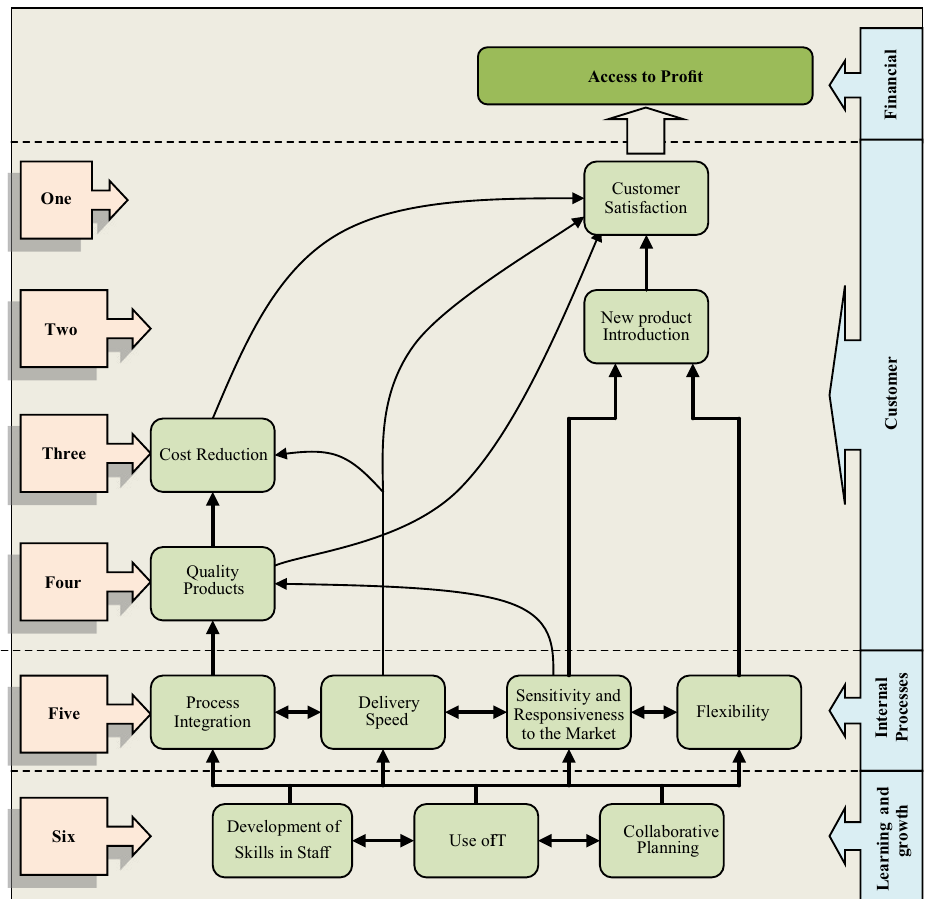
Fig. 4. Proposed agile supply chain criteria for the steel